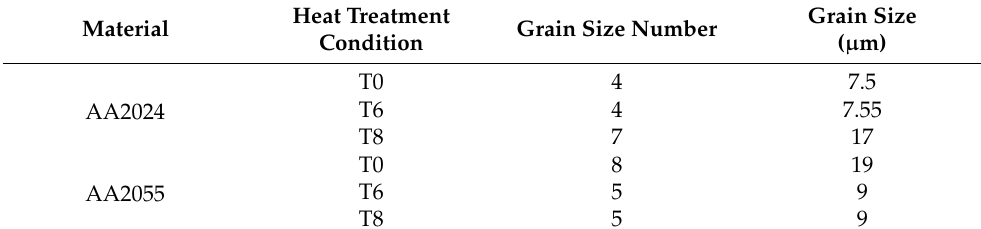
Table 2. Grain size for aluminum alloys AA2024 and AA2055 with different heat treatments.